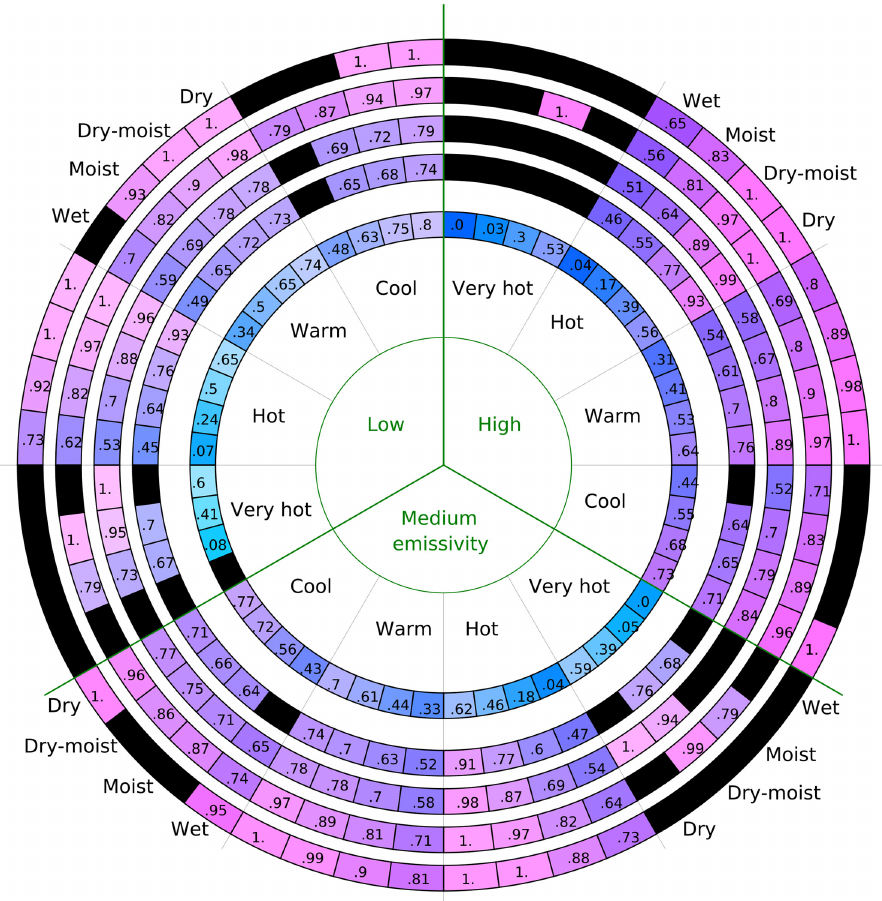
Figure 7. Mean colours simulated by COSMO-MUSCAT-RTTOV, subdivided into the ranges of emissivity (low–high), skin temperature (cool–very hot), and column moisture (dry–wet), as defined in Table 2. Values increase in an anti-clockwise direction, as indicated. The innermost ring is the “near-pristine” case, with AODs < 0 . 2. The four remaining rings are the thick dust cases with AODs between 2 and 3, subdivided by height ranges. From the inner to the outer rings, the dust height ranges represented are 0–1, 1–2, 2–3, and 3–4km (Layers 1–4). A total of 0.2% of the points in this AOD range have a dust height greater than 4km, while no points in this range have a skin temperature of less than 286K (“cold”). All 3-hourly time slots from day and night are included. The numbers marked on each segment indicate the mean red value, to two decimal places; leading and ending zeroes have been removed for brevity. Black segments indicate coincident conditions not contained within this data